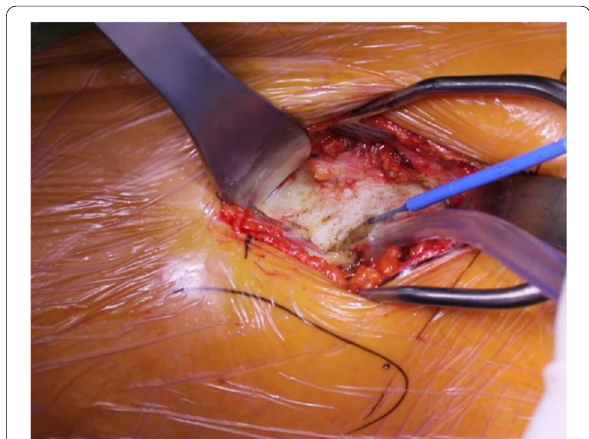
Fig. 4 Homman retractor inserted medially between the anterior fat pad and the capsule with commencement of the capsulotomy